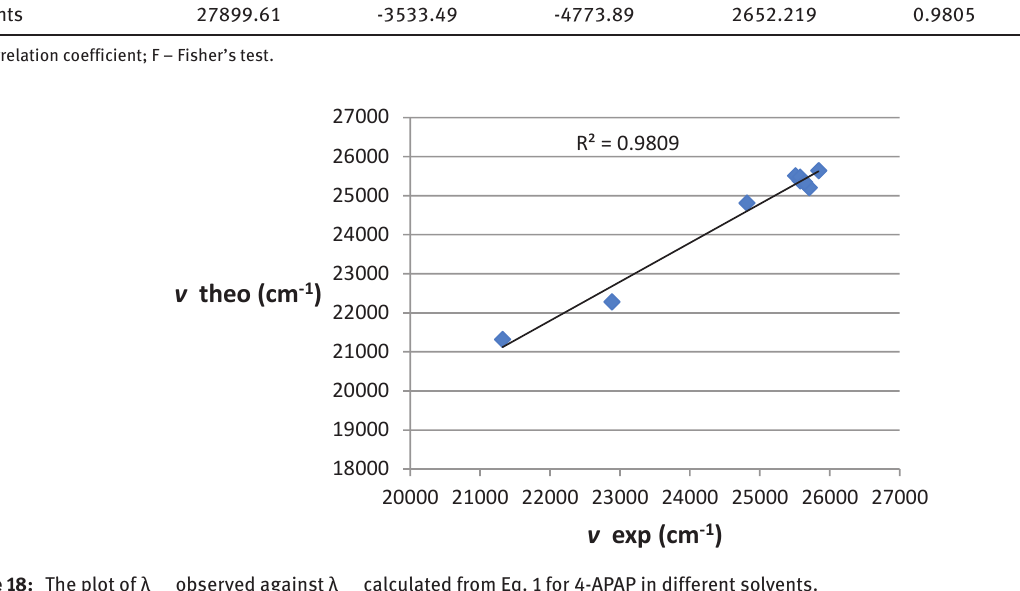
Figure 18: The plot of λ